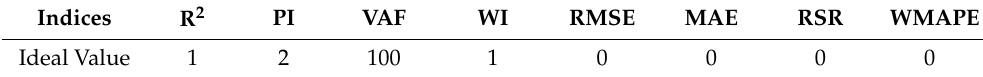
Table 2. Ideal values of different performance